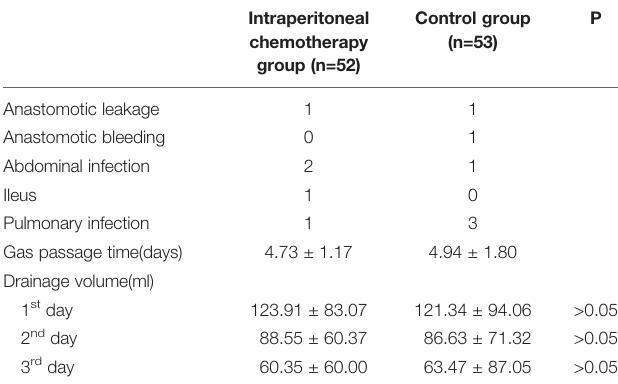
TABLE 4 | Postoperative complications and surgical outcomes in the two